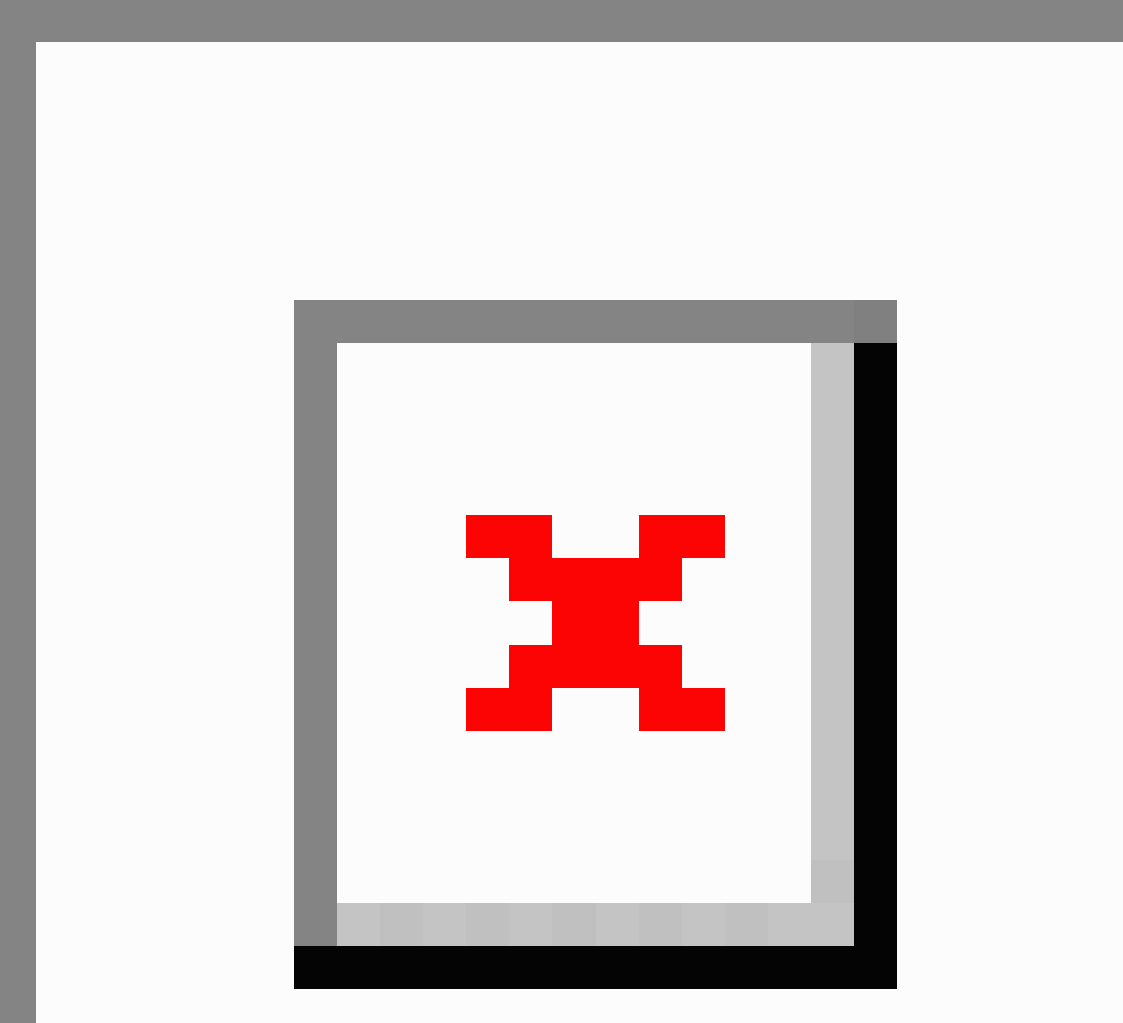
Figure 1. Possible combinations of the base element and three optional elements involved in clinical use of PRO. Base: PRO data collection and logistic, Element 1: PRO-based overview for clinical decision support, Element 2: PRO-based automated decision algorithms, Element 3: Other forms of